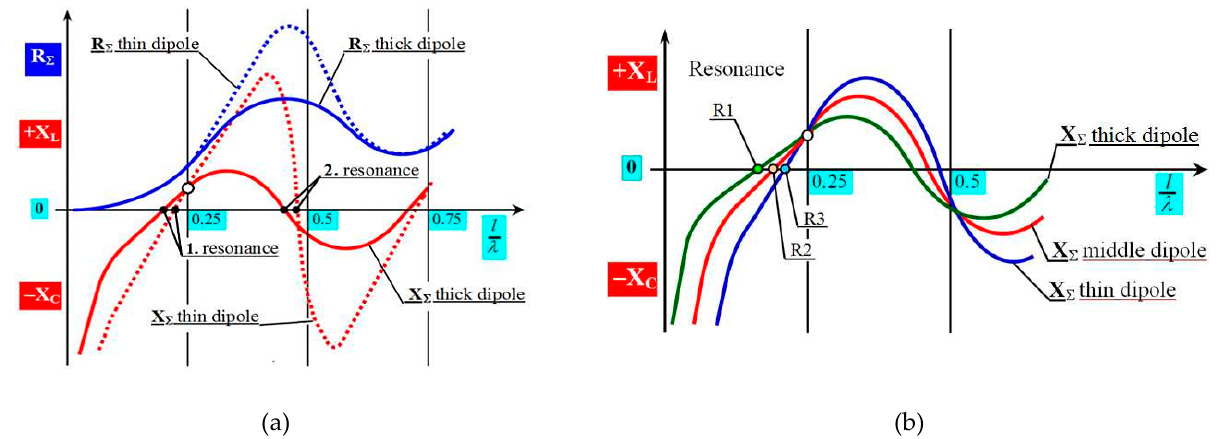
Figure 5. Influence of antenna conductor thickness on its impedance: ( a ) Antenna thickness and its impedance in the area of the 1st and 2nd resonance; ( b ) Antenna thickness and position of reactance resonance points.